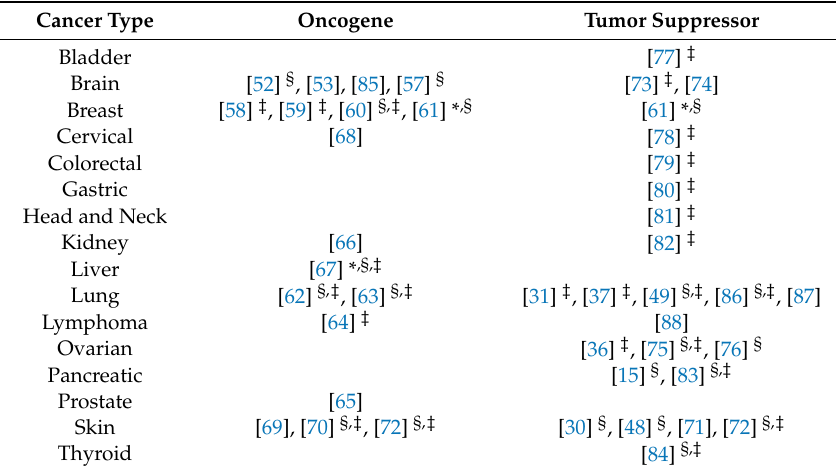
Table 1. A summary of the role of RhoB in several cancer